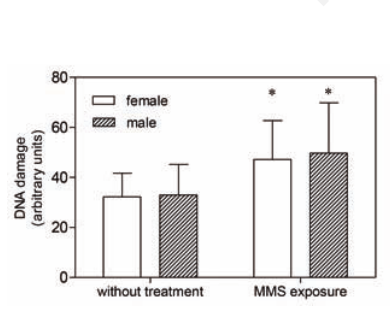
Figure 3. DNA damage measured in Morus bassanus erythrocytes before and after methyl methane sulfonate (MMS) exposure (mean±SD; female N=6; male N=10). *Denotes statistically significant difference (P<0.05) compared to batches without